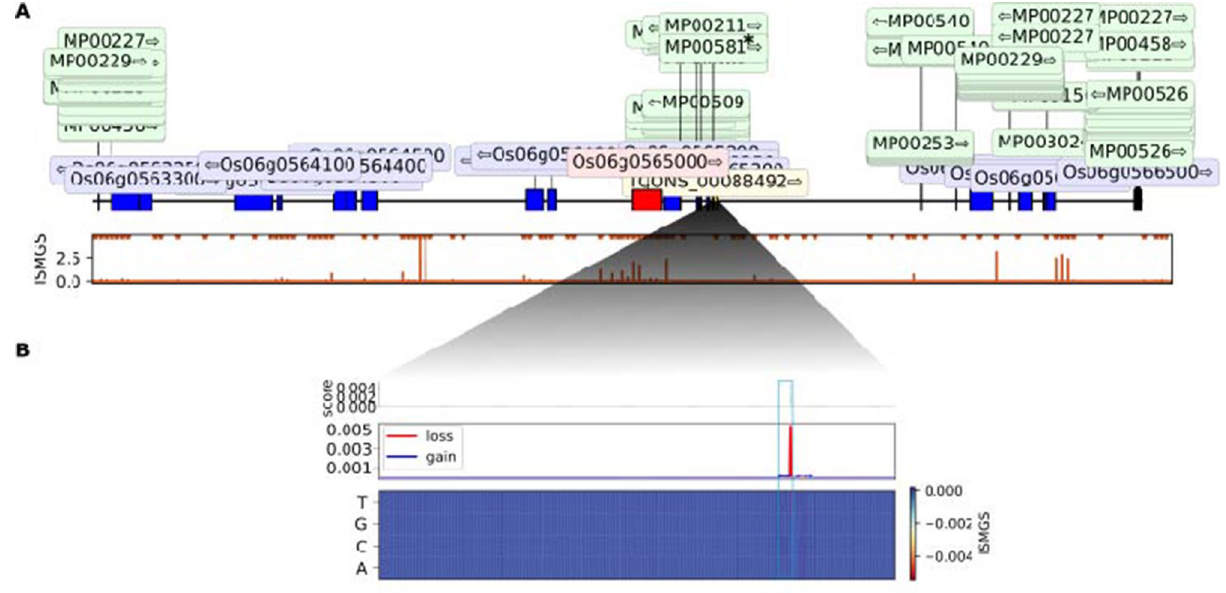
Figure 5. In silico mutagenesis of lncRNA.2-FL. ( A ) The top panel shows a 200 kb neighboring window around cis -regulatory target gene “Os06g0565000” (red). All the other genes are marked in blue, transcription factors (TFs) in green and lncRNA.2-FL in yellow. The predicted mutagenesis score and its significant peaks is shown in the panel below. ( B ) This panel display mutagenesis of every base within lncRNA.2-FL to other possibilities and their effect on the TSS of Os06g0565000. The location of TF MP00581 is marked with a blue box. TFBS Up/down Distance TF.ID TF familyStart